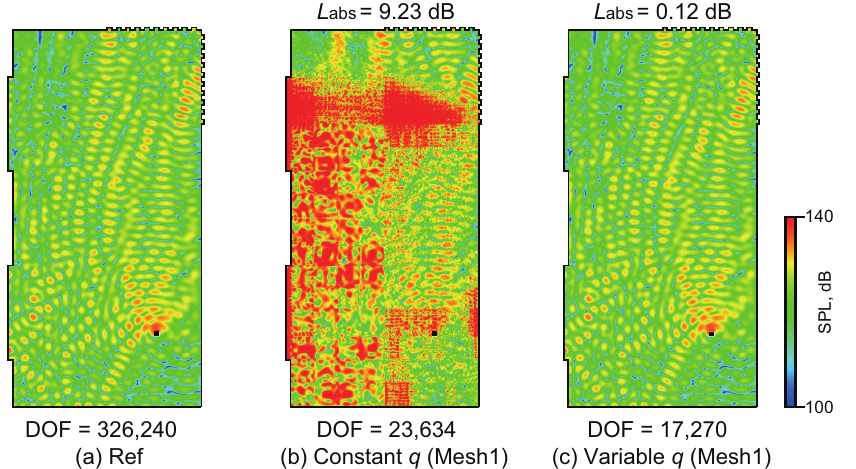
Figure 5. A comparison of the SPL distribution at 1 kHz among ( a ) the reference solution, ( b ) the PW-FEM using the Constant q -approach, and ( c ) the PW-FEM using the Variable q